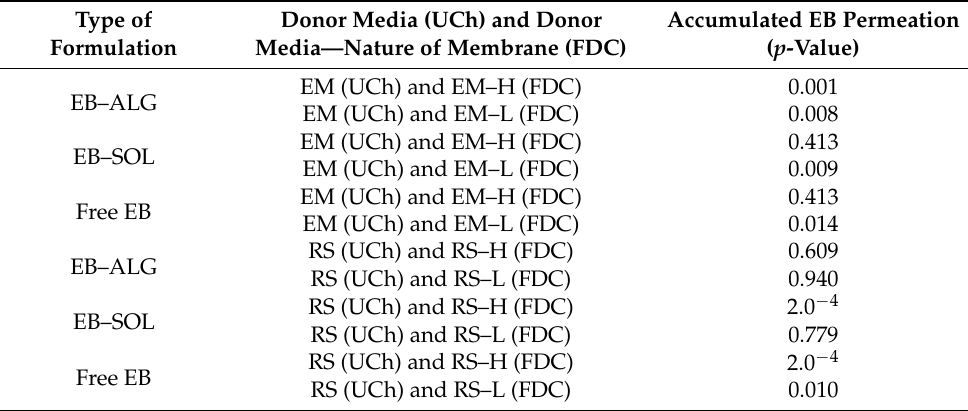
Table A3. Analysis of variance (ANOVA) between synthetic and biological membrane in the apparent permeability